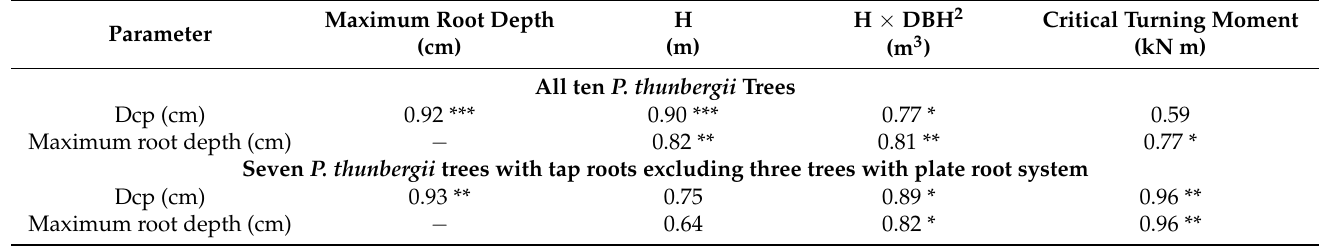
Table 2. Pearson coefficients for correlations among traits of Pinus thunbergii